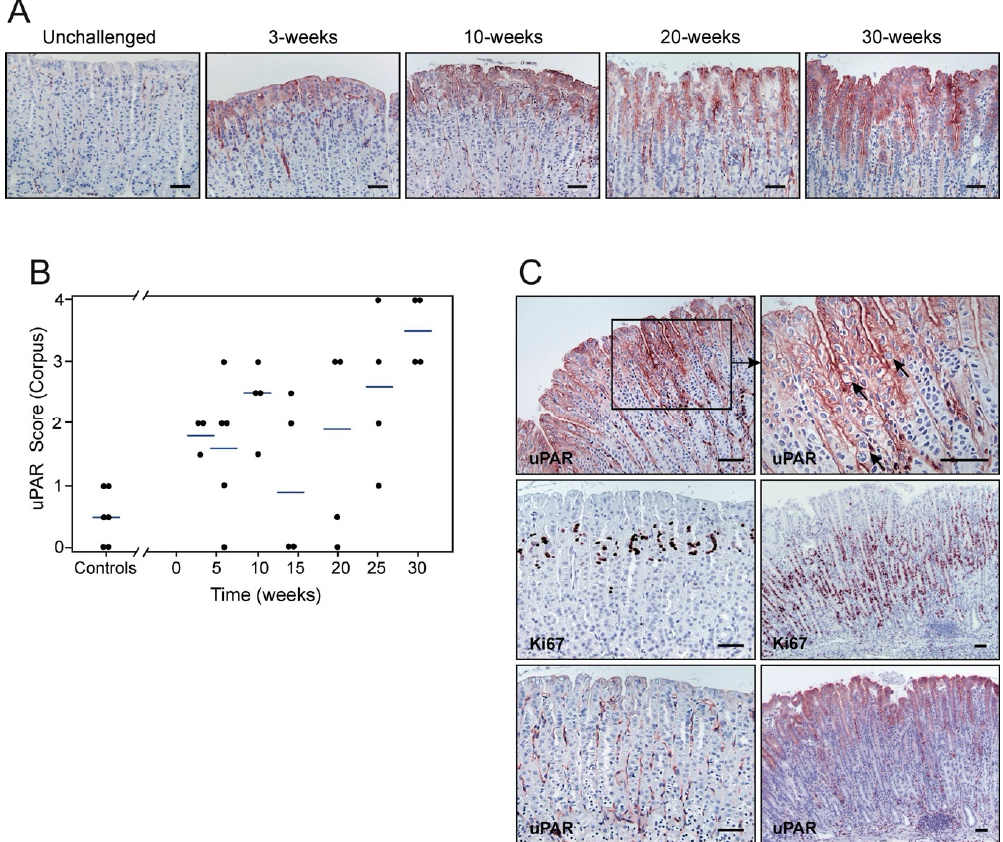
Figure 4. Kinetics of H. pylori -induced uPAR expression and cell proliferation in the gastric epithelium. Sections from unchallenged, 3-, 10-, 20-, and 30-week post-inoculation (PI) mice were examined by immunohistochemistry for uPAR ( A , C ) and Ki67 ( C ) expression. Semi-quantitative assessments reveal a progressive increase in uPAR intensity ( B ; p = 0.006; r s = 0.57) (one experiment; n = 9 controls; n = 4–5 H. pylori -challenged mice per timepoint), which is correlated with cell proliferation ( p < 0.0001; r s = 0.70). Corresponding uPAR and Ki67 staining on adjacent sections from non-infected (left) and infected (right) mice are shown ( C ). Arrows indicate the presence of mitotic figures. Scale bars ≈ 100 µ